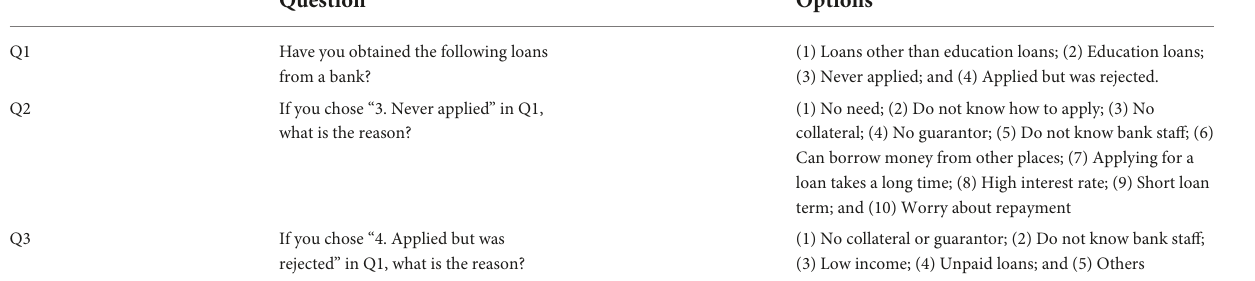
TABLE 2 List of credit exclusion questions.